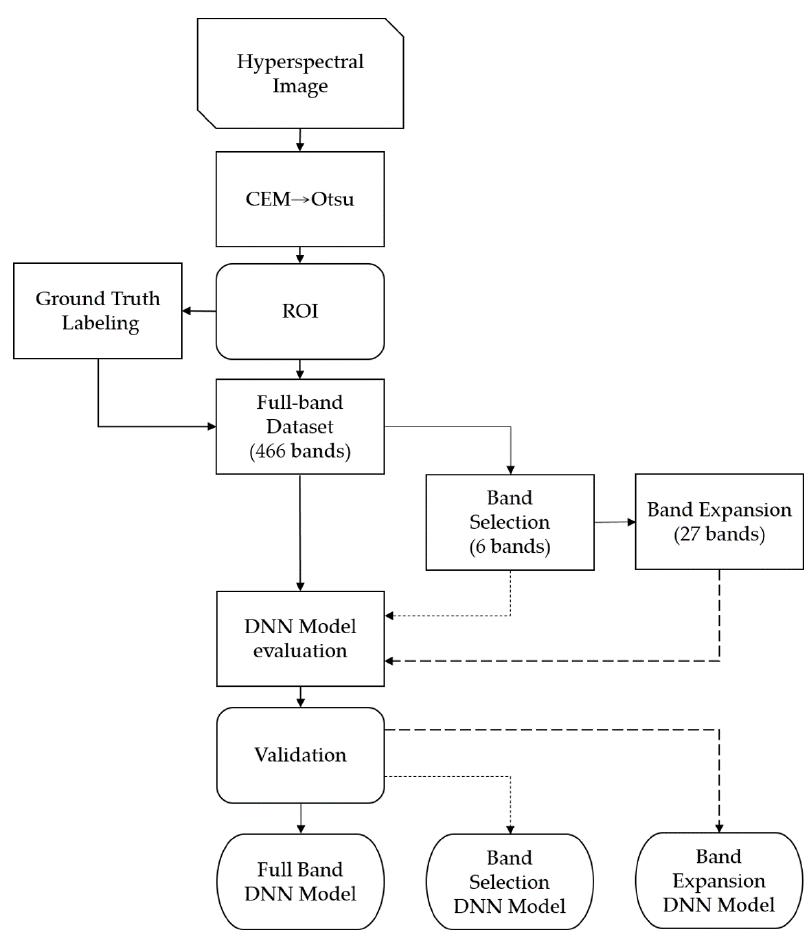
Figure 5. Data training flowchart of full bands, band selection, and band expansion